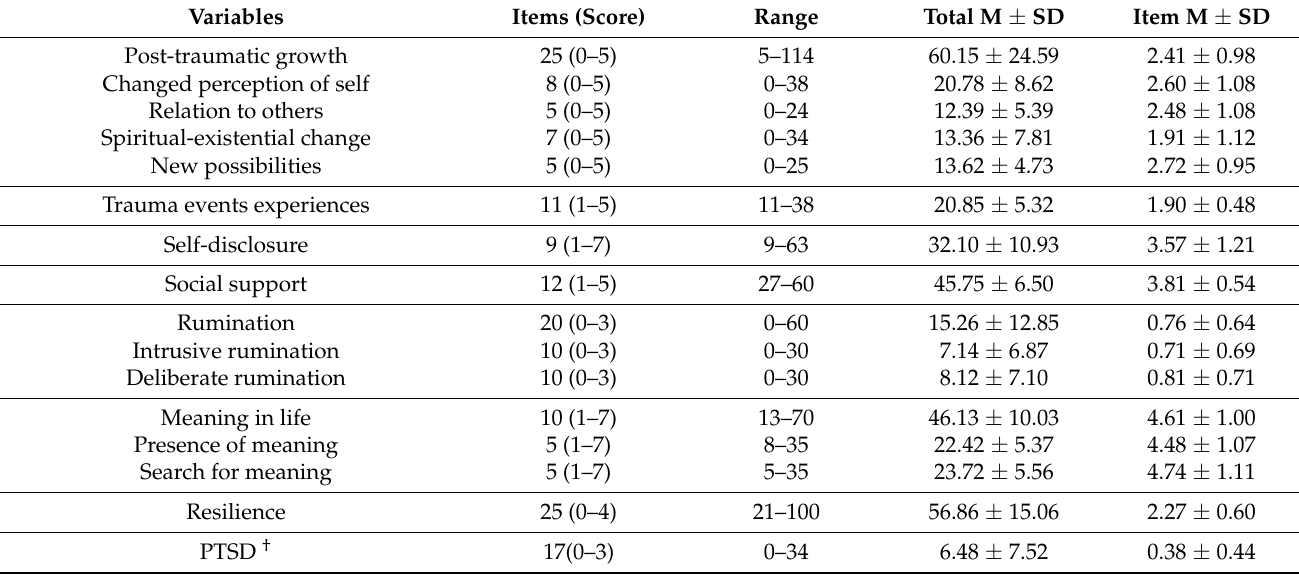
Table 2. Level of the research variables (N = 233).